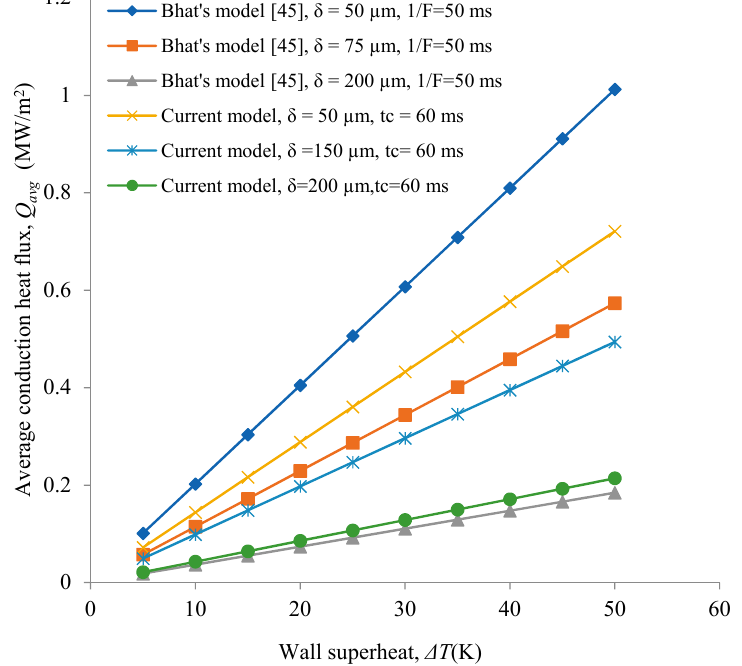
Figure 4. Prediction of average conduction heat fluxes with wall superheat ( t c = 60 ms, 1/F = 50 ms).